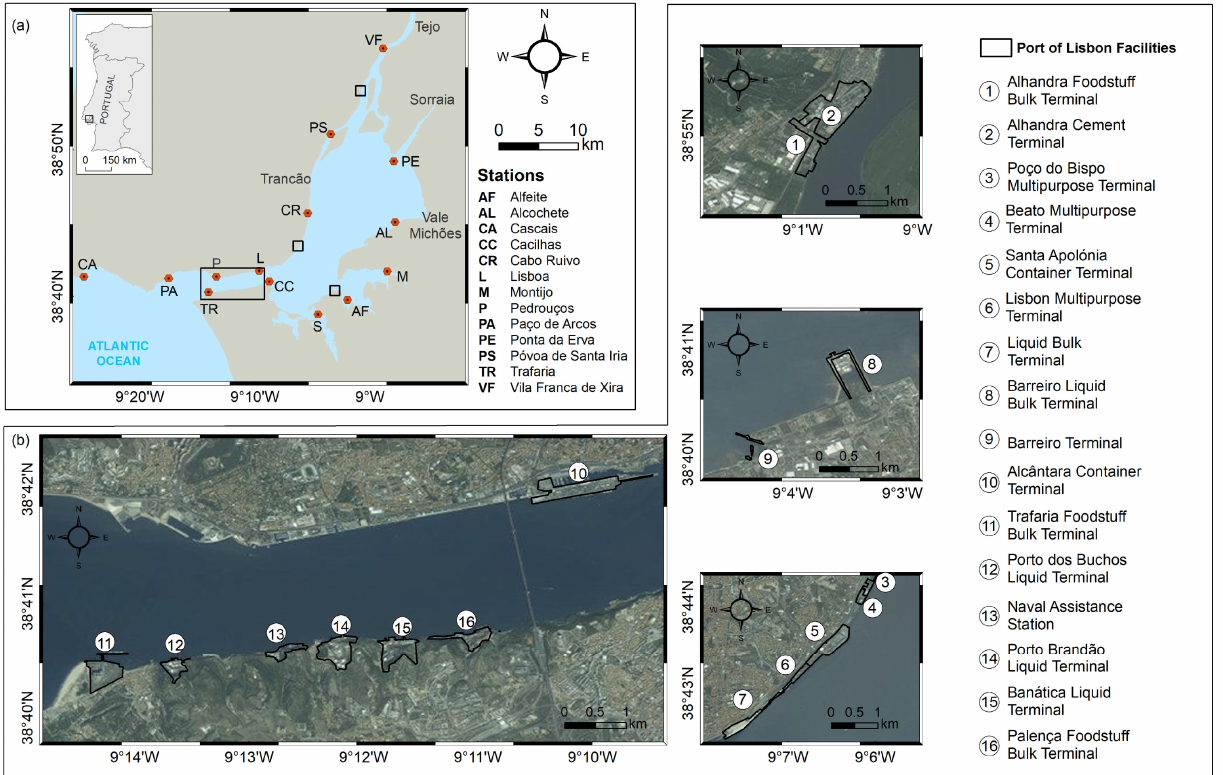
Figure 5. Study area with the in-situ stations ( a ) used to validate the hydrodynamic model (data retrieved from [87]). Location of the Lisbon port and the business areas in the port administration jurisdiction ( b